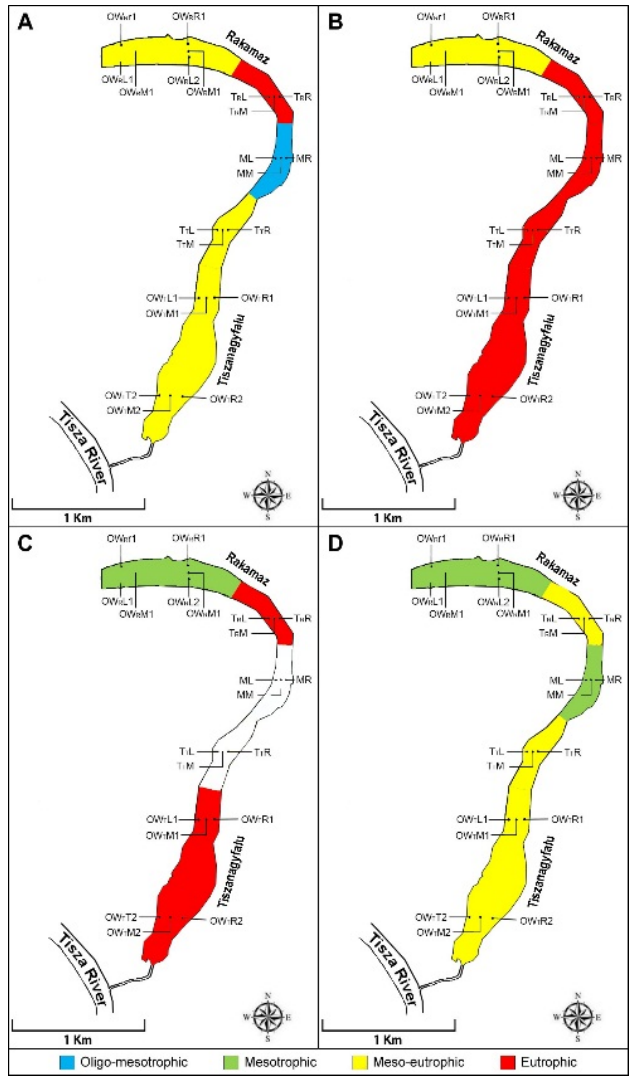
Figure 5. ( A ) April; ( B ) June; ( C ) July; ( D ) October. Trophic levels in various zones. OW R represents the open water zone of the Rakamaz area with the sampling transects and the sampling points. T R represents the transitional zone between the open water zone of Rakamaz area (OW R ) and the Middle zone (M) which is characterized by a large macrovegetation coverage. T T represents the Transitional zone between the open water zone of the Tiszanagyfalu area (OW T ) and the middle zone (M). OW T represents the open water zone of the Tiszanagyfalu area. The numbers 1 and 2 represent the transects inside the zones. The letter L represents the left parts of the transects, M represents the middle parts of the transects, and R represents the right parts of the transects; these abbreviations apply to all sampling points. The color scale represents the various trophic levels: blue means oligotrophic; lemon yellow means mesotrophic; orange means meso-eutrophic; red means eutrophic trophy level; white means impossible to